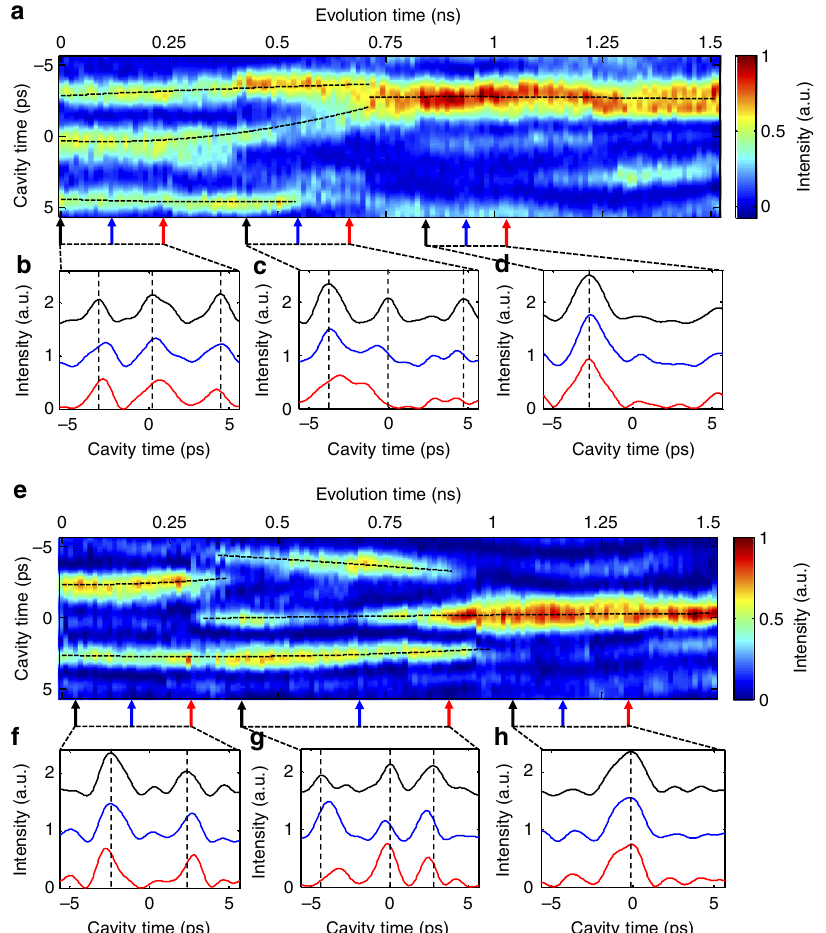
Fig. 5 Dissipative Kerr soliton dynamics measured by the PARTI system. a An example 2D evolution portrait, depicting soliton fusion dynamics and transition from a triplet soliton state to a singlet soliton state. b – d Measured waveforms at different evolution time slices in each stage, illustrating stable triplet solitons at the beginning stage ( b ), soliton fusion at the middle stage ( c ) and stable singlet soliton in the fi nal stage ( d ). e Another example 2D evolution portrait, showing an evolution from doublet solitons to triplet solitons and eventually to a singlet soliton. f – h Measured waveforms at different evolution time slices in each stage, illustrating soliton repulsion at the beginning stage ( f ), soliton attraction at the middle stage ( g ) and the stable singlet soliton at the fi nal stage ( h ). For a and e , black dashed curves emphasizing the soliton transition traces are plotted against the 2D portrait. For b – d and f – h , three waveforms at different time slices are plotted in each stage, which are represented in black , blue and red , respectively. Coloured arrows indicate the temporal positions where the waveforms with the corresponding colours are measured. Vertical black dashed lines are plotted according to the soliton positions of the fi rst slice to emphasize the position change of solitons at different time